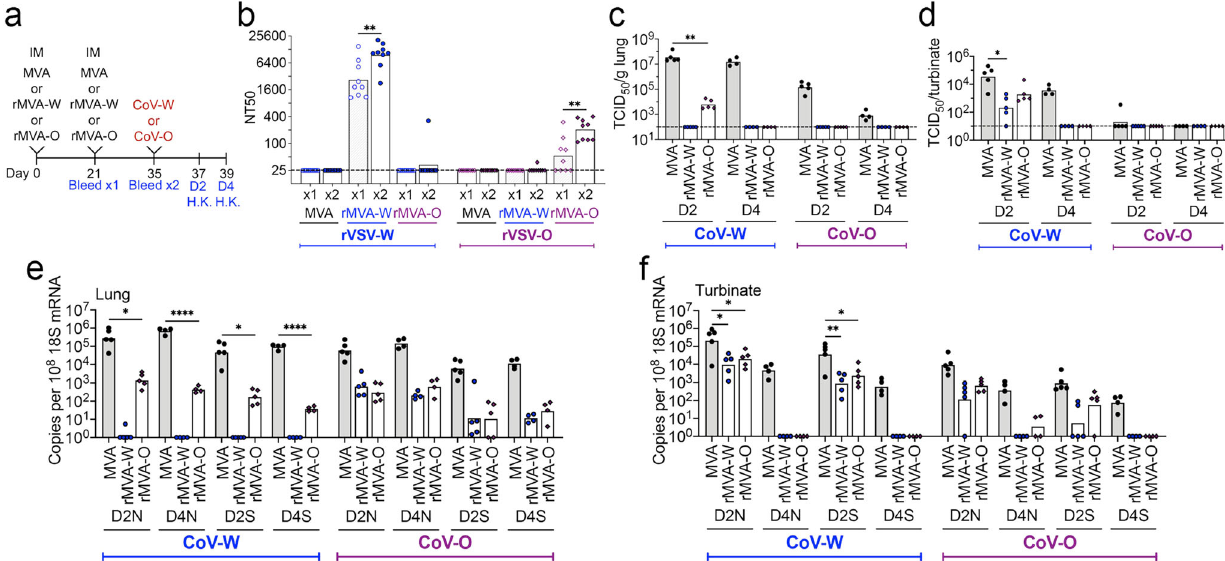
Fig. 6 Protection of mice immunized IM with rMVAs to matched or mismatched CoVs. a Timeline showing IM immunizations of K18-hACE2 mice ( n = 9 per group) with 2×10 7 PFU of MVA, rMVA-W or rMVA-O and matched and mismatched challenges with 10 4 TCID50 of CoV-W and 5x10 4 TCID 50 of CoV-O. Mice were H.K on day 2 ( n = 5) and day 4 ( n = 4). b Neutralization of pseudoviruses rVSV-W and -O by serum obtained after one and two IM immunizations with MVA, rMVA-W or rMVA-O. n = 9 per group. Recovery of SARS-CoV-2 from (c) lungs and (d) nasal turbinates on days 2 and 4 after challenge with CoV-W or CoV-O. Copies of sgRNAs N and S relative to 18 S RNA from (e) lungs and (f) nasal turbinates on days 2 and 4 after challenge. Statistics: for panels b and c Mann-Whitney; d-f ANOVA with Dunnet post-hoc. * p ≤ 0.03; ** p ≤ 0.002; **** p < 0.0001. Dotted line, limit of